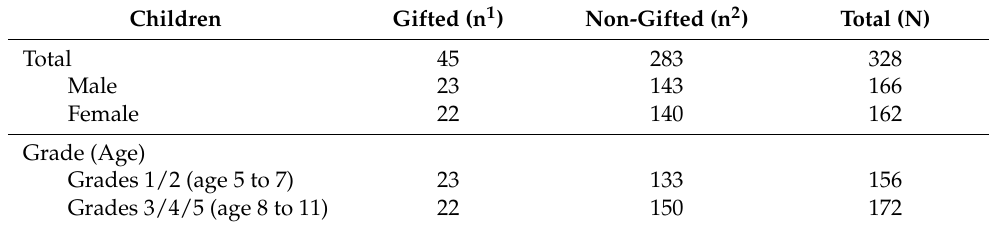
Table 1. Descriptive statistics of the overall sample used in the study.